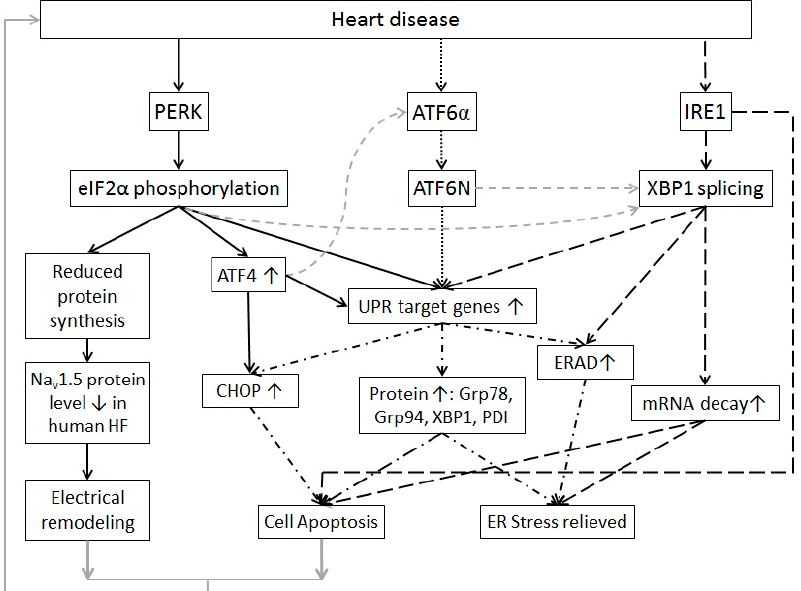
Figure 1. A scheme of signaling pathways of the unfolded protein response with its sensors, downstream effectors, targeting genes, and possible outcomes. The PERK branch (linked by black-solid arrows) can be activated in human heart failure, diabetes hearts and ischemia/reperfusion, leading to inhibition of nascent protein synthesis and ATF4 elevation [10–13]. Elevated ATF4 can induce expression of CHOP and other UPR target genes. The ATF6 branch (linked by black-dotted arrows) is reported to be activated in early stage of ischemia and mainly induces UPR target genes expression [14–16]. The IRE1 branch (linked by black-dashed arrows) is reported to be activated in human heart failure and ischemia/reperfusion [12,17,18]. Its downstream effectors activate the ERAD and ER-localized mRNA decay [5]. The IRE1 branch has also been reported to promote cell apoptosis via Jun N-terminal kinase and p38 MAPK [19]. All three branches cause UPR target genes expression (linked by dash dotted dash arrows) such as the UPR chaperones Grp78 and Grp94 and ERAD proteins to help misfolded/unfolded protein refold or degrade. There is also crosstalk among the three branches (linked by gray dashed arrows). Under short-term and mild ER stress, the UPR is adaptive to release the ER stress; while under prolonged and severe ER stress, the UPR leads to cell apoptosis and electrical remodeling (due to decreased cardiac ion channels) that will harm the cardiac function and lead to heart diseases (linked by gray arrows).